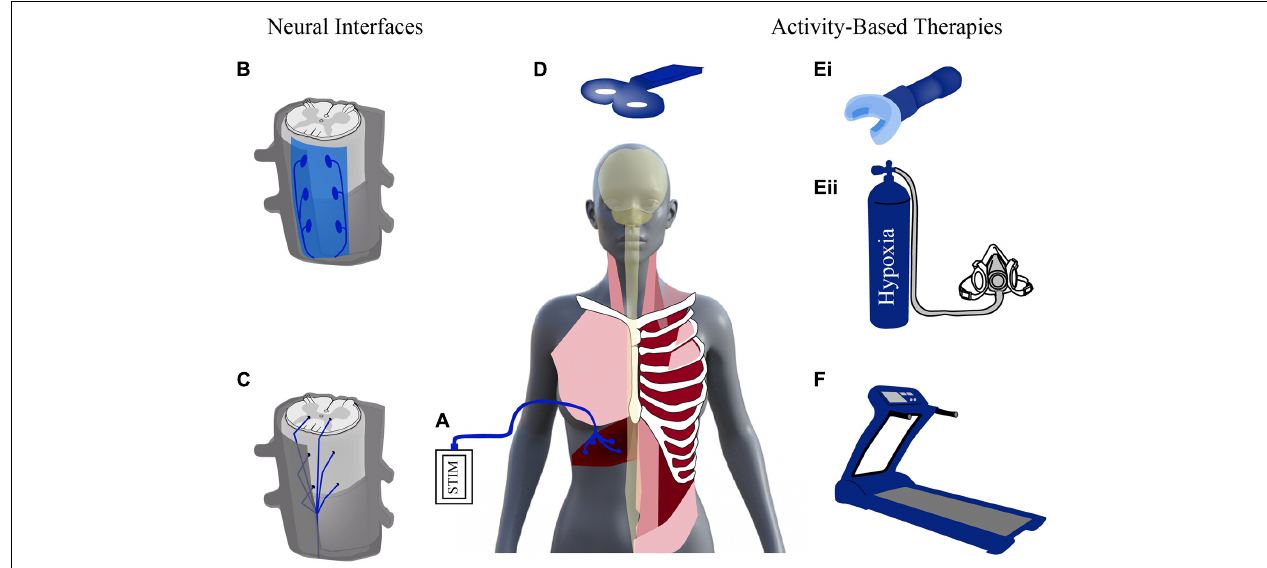
FIGURE 2 | Stimulating activity to enhance plasticity. Schematic diagram of neural interfaces (left) and activity based (right) strategies to drive neural activity. Neural interfaces include strategies that can be applied to the periphery [e.g., functional electrical stimulation of diaphragm via diaphragm pacer, (A) ]. Electrical stimulation can be applied to the spinal cord via epidural stimulation (B) and intraspinal stimulation (C) as well as non-invasively, supraspinally, via transcranial magnetic stimulation (D) . Activity-based therapies use physical stimuli to result in increased respiratory drive and neural stimulation via strategies like resistance training (Ei) or intermittent hypoxia (Eii) , and locomotor training, e.g., via treadmill (F) . Modified from Hormigo et al. (2017), Zholudeva et al.